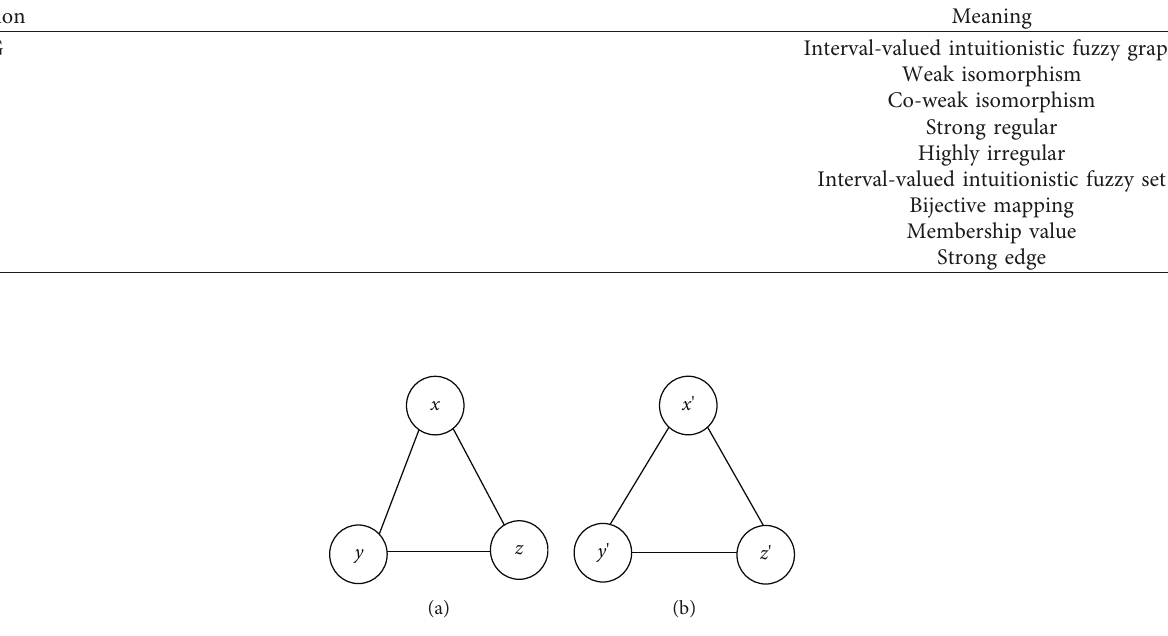
Figure 1: h -morphism of m -polar IVIFGs G